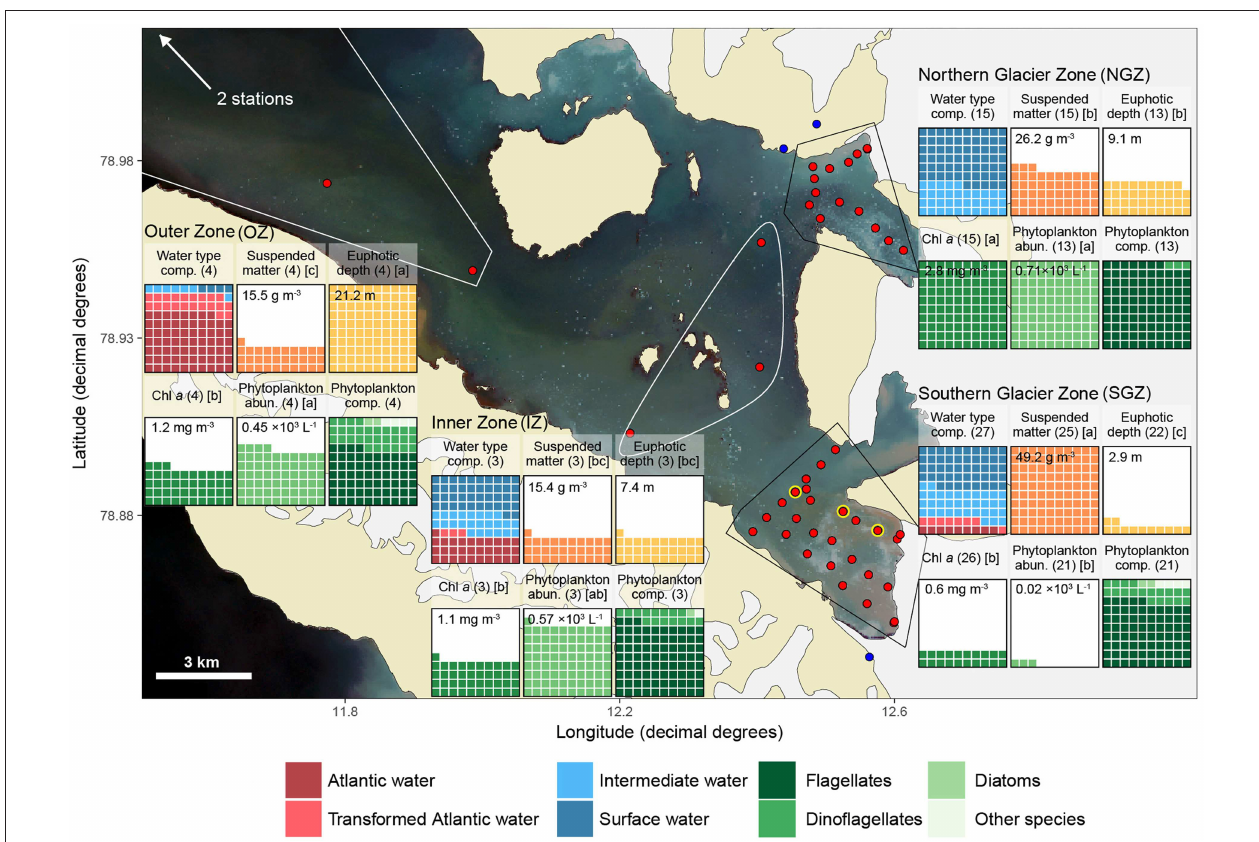
FIGURE 2 | Overview of sampling locations and major differences among them. Red dots indicate ship or helicopter-based sampling stations, yellow circle locations where sediment cores were collected, and blue dots sampling from terrestrial glacial meltwater rivers originating from land-terminating glaciers. Waffle charts are arranged in 10 × 10% grid with each cell representing 1% of maximum average value for a variable across all zones for all boxes except the first and last one, which are scaled to mean value within each zone (i.e., represent composition). Polygons bound the stations within each zone. The satellite photo in the background obtained on 31 July 2017 from Sentinel-2 (https://scihub.copernicus.eu/) shows the water colour during sampling. Suspended matter and Chl a values were averaged for the upper 10m for each station. Other variables represent values for the entire sampling range (0 m-bottom). Numbers in brackets after waffle-chart headers indicate number of replicates and letters indicate multiple comparisons test results: differing letters indicate statistically significant differences between zones for each variable, respectively. Mean values are given for non-compositional parameters in each box. See Table 1 for mean values, ranges, and standard